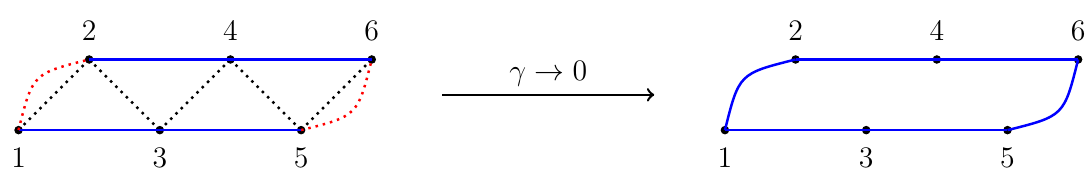
Figure 12 . The graphical interpretation of the terms in the Hamiltonian (4.13) for a chain of length 2 L = 6 are shown in the left part of the figure. The nearest-neighbour interaction is represented by dotted black lines, the XXX next-to-nearest neighbour interaction by solid blue lines, and the boundary interactions by the dotted red lines between sites 1 and 2 and between sites 5 and 6 . The three-site interaction is not represented here. The right part of the figure shows the interactions in the limit γ → 0 , where one observes that the Hamiltonian becomes equivalent to a periodic XXX